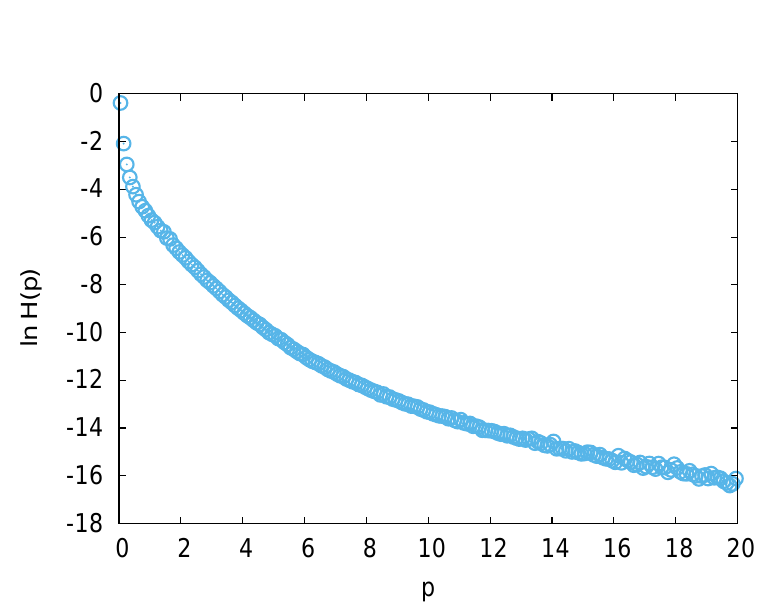
Figure 20: Histogram of the electron momenta contributing to the (full) self-energy in the bare expansion.